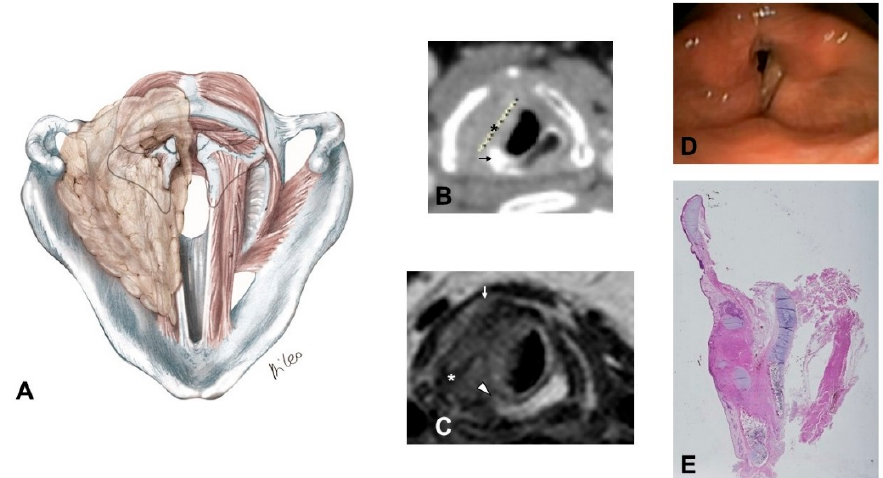
Figure 5. Pattern 4: Transglottic-hypoglottic carcinoma with massive invasion of the crico-arytenoid unit and involvement of the posterior crico-arytenoid muscle, reaching the hypopharyngeal submucosa: ( A ) Axial scheme; ( B ) Axial CE-CT image at the level of the cricoid lamina shows a right-side neoplastic mass with homogeneous enhancement (asterisk). The right cricoid cartilage demonstrates sclerosis suspicious for neoplastic invasion (arrow); ( C ) Axial T2-weighted MR image at the same level: right cricoid cartilage shows signal alteration (arrowhead) similar to intermediate tumor signal intensity, indicative of invasion. The lesion extends to the right crico-thyroid space which appears enlarged (asterisk). Thyroid cartilage is invaded and extra-laryngeal neoplastic spread is observed (arrow); ( D ) Endoscopic view ( E ) Whole organ section in sagittal view: massive involvement of the cricoid plate.